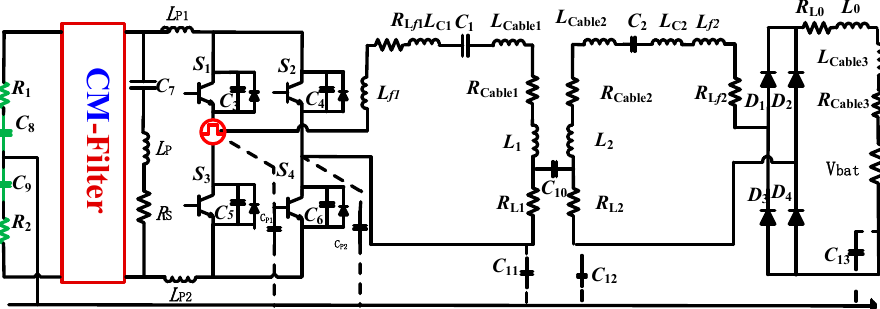
Figure 19. WCS circuit with the CM filter.